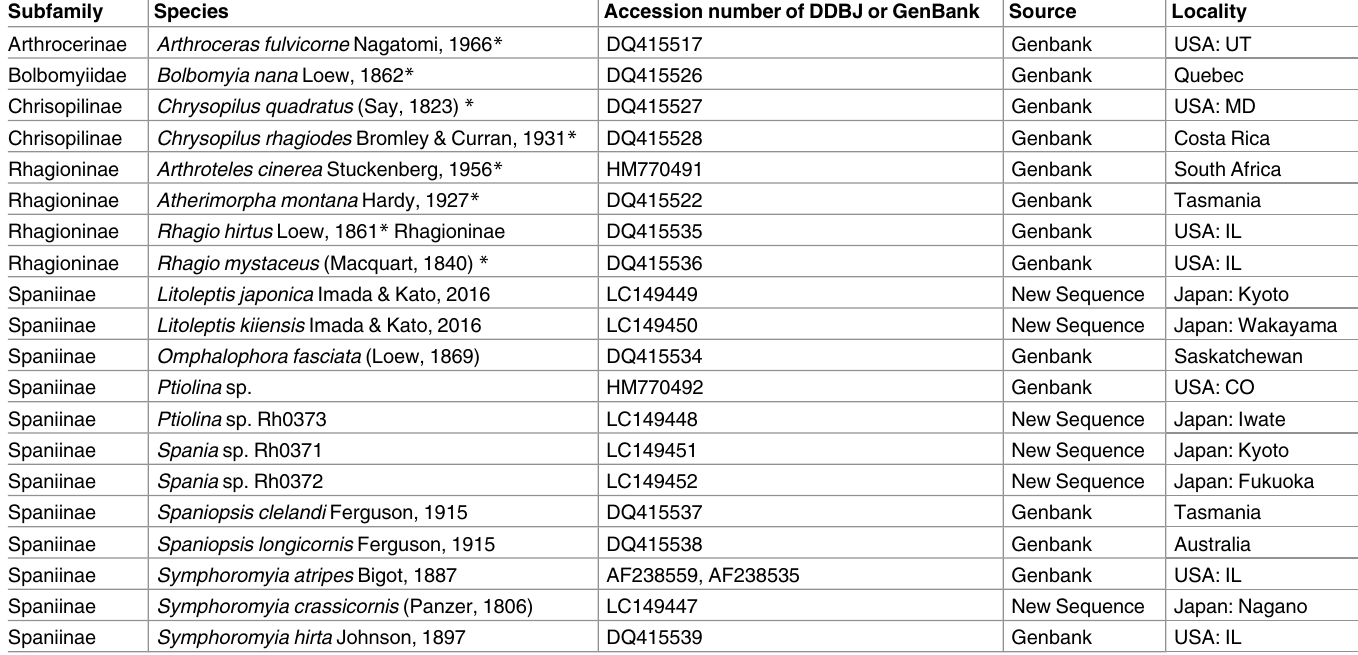
Table 1. Samples used for the molecular phylogenetic analyses. The arrangement of subfamilies adopted here is based on [16]. Samples shown with asterisk ( * ) were used as the outgroup taxa. Accession number of DDBJ or GenBank